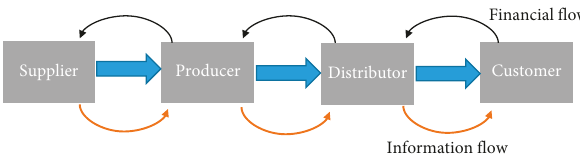
Figure 1: The flows in a supply